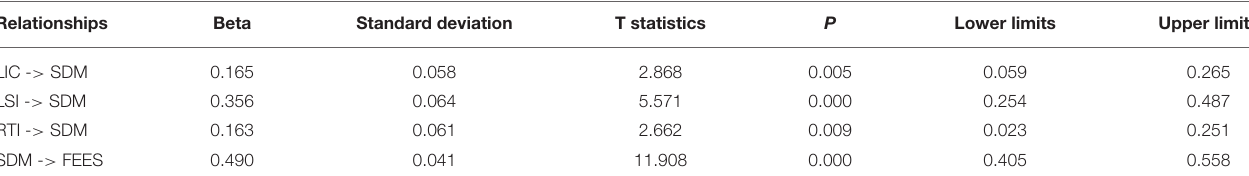
TABLE 4 | Direct path.